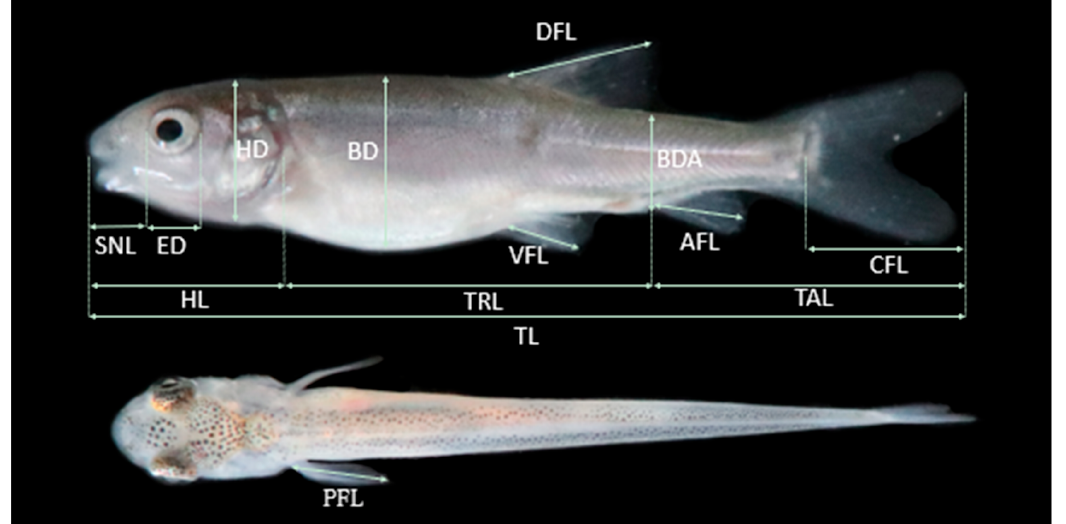
Figure 1. Schematic diagram of morphological and metric indicators in the larvae. AFL, anal fin length; BD, body depth; BDA, body depth at anus level; CFL, caudal fin length; DFL, dorsal fin length; HL, head length; HD, head depth; ED, eye diameter; PFL, pectoral fin length; SNL, snout length; TAL, tail length; TRL, trunk length; TL, total length; VFL, ventral fin length.